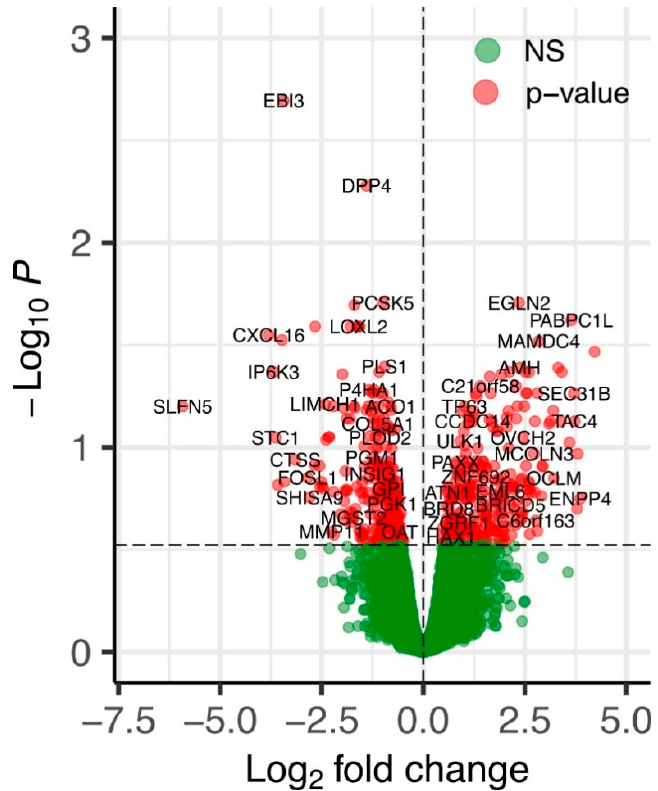
Figure 1. A volcano plot of differentially expressed genes in ERAP2N-positive vs. ERAP2N-negative trophoblast cells. X-axis—log2 fold change. Y-axis—( − log10) edgeR-calculated p-values. Red points correspond to significantly differentially expressed genes. Green points correspond to genes unchanged (NS: not significant) by ERAP2N expression level.